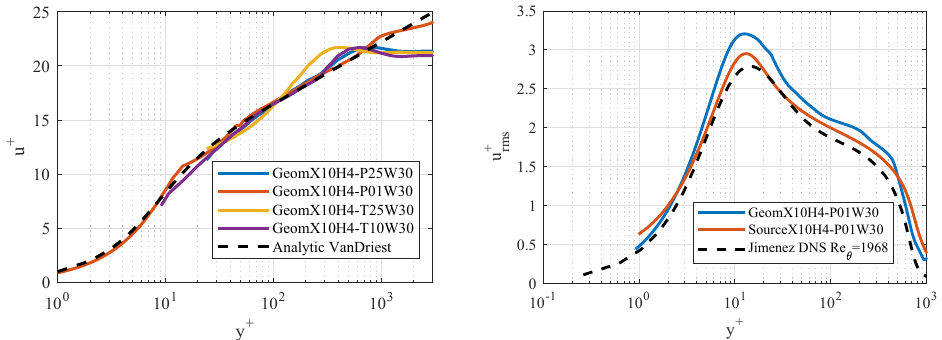
Figure 2. Mean and RMS velocities as a function of y + for different LES cases using different near-wall mesh type and refinements ( left ), and tripping methods ( right